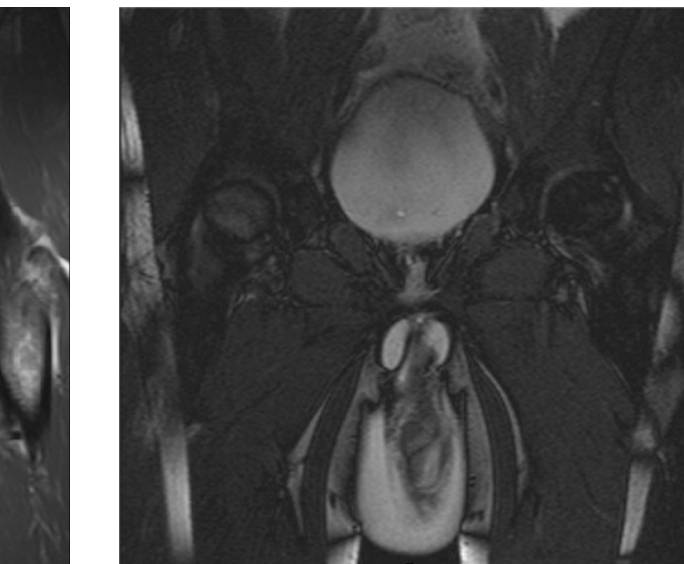
Figure 1 - Coronal T1 image shows disruption of the low intensity inferior left tunica albuginea and associated low signal corpus cavernosal hematoma at the base of the penis.